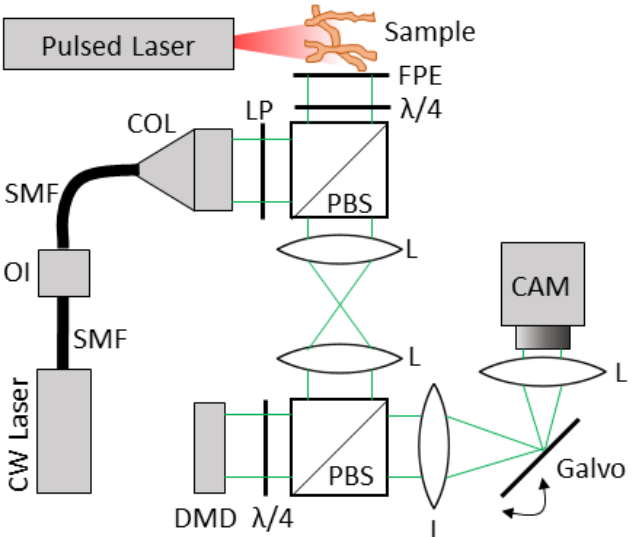
Figure 1. The proposed optical system. SMF = single-mode fiber, OI = optical isolator, COL = collimator, PBS = polarized beam splitter, λ /4 = quarter wave plate, L = lens, CAM = camera, DMD = digital micromirror device, LP = linear polarizer, FPE = Fabry–Pérot